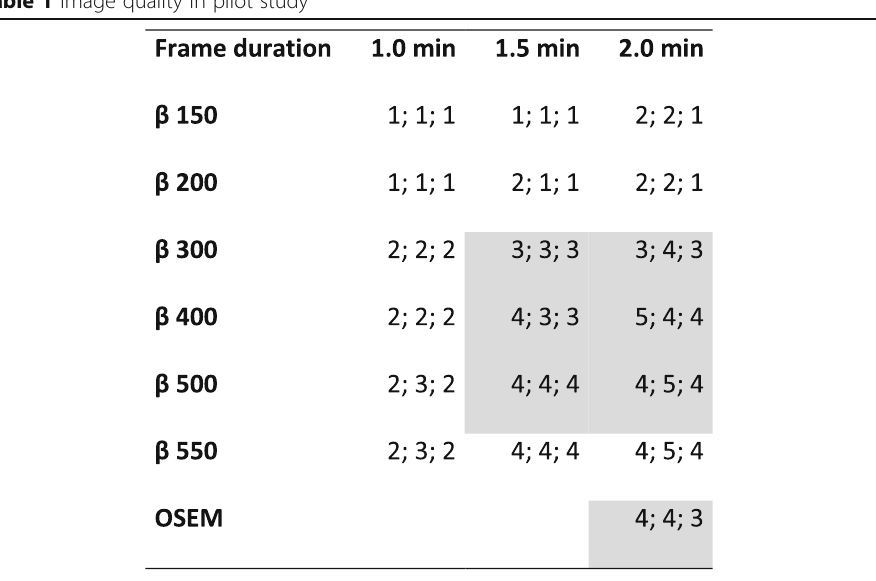
Table 1 Image quality in pilot study